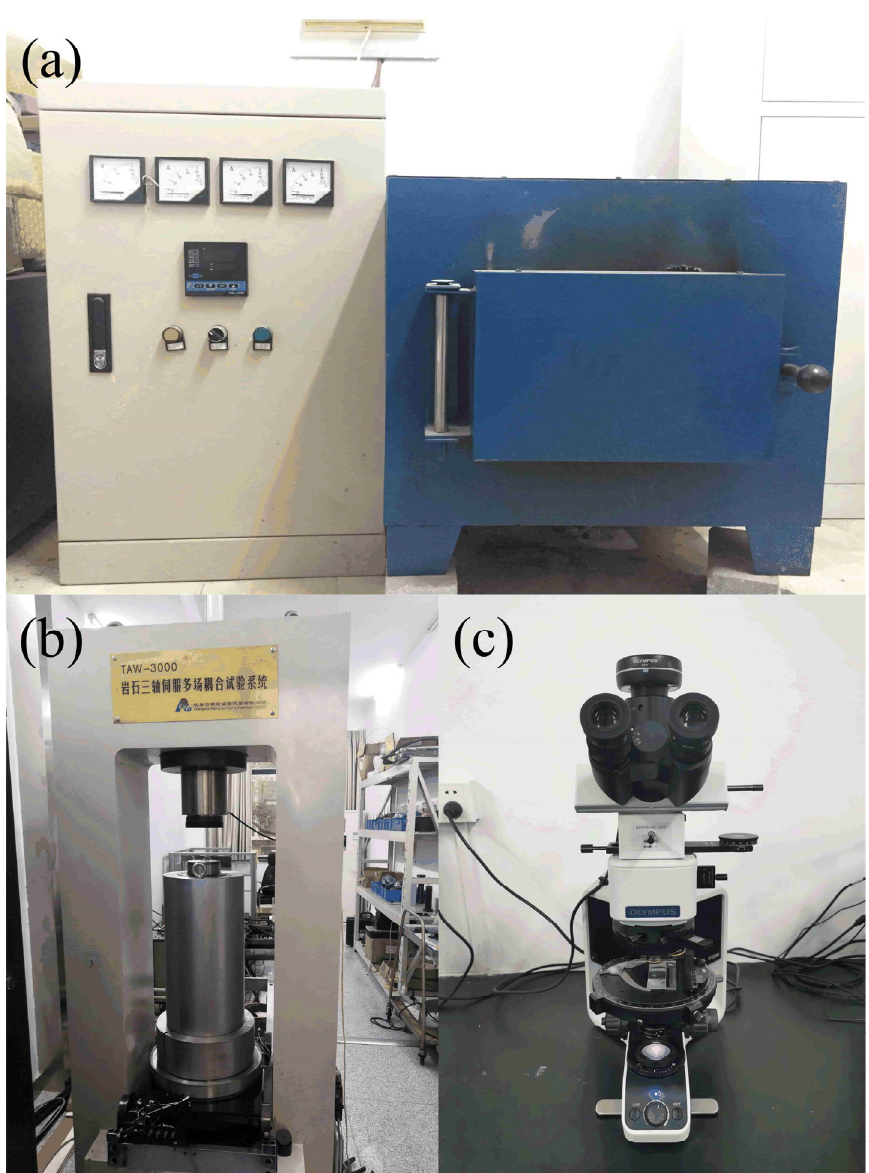
Figure 2. Test equipment: ( a ) SX2 ‐ 10 ‐ 12 high ‐ temperature box ‐ type resistance furnace; ( b ) TAW ‐ 3000 rock triaxial servo multi ‐ field coupling test system; ( c ) photograph of Olympus BX53M polarizing microscope.